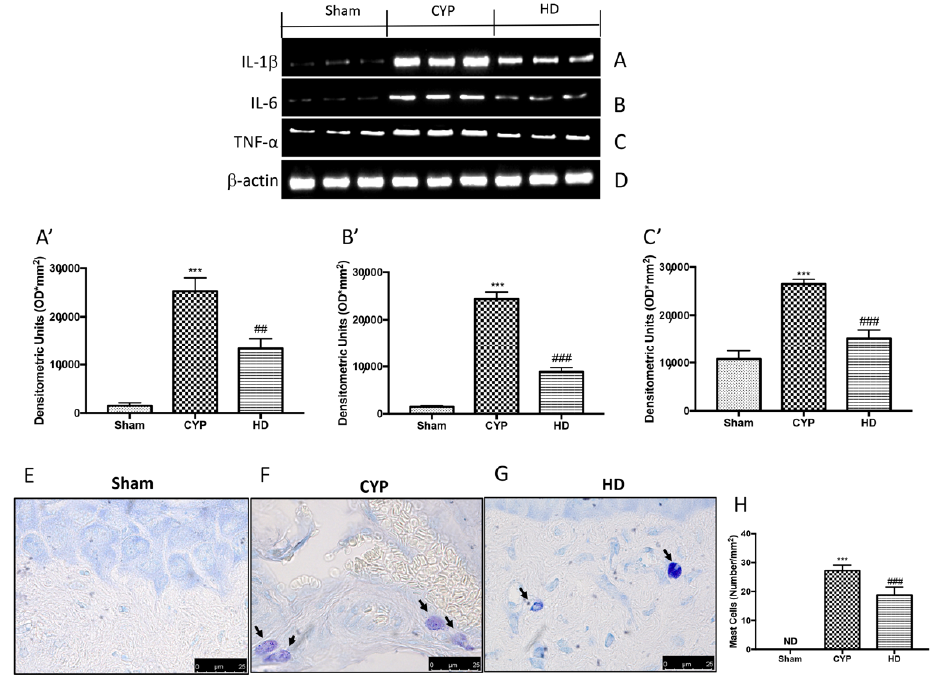
Figure 4. Effect of HD on the release of proinflammatory cytokines and mast cell (MC) activation in the bladders of mice after repeated CYP injections. Western blot analysis showed that IL-1 β expression was significantly increased in the CYP group, while treatment with HD decreased the expression of IL-1 β ( A , A’ ). IL-6 expression was increased after repeated CYP injections; treatment with HD decreased levels of this cytokine ( B , B’ ). TNF- α expression was significantly increased in the CYP group, while treatment with HD decreased the expression of TNF- α ( C , C’ ). Mast cell infiltration was evaluated by toluidine blue staining in the chronic cystitis model. Mast cells were characterized by dark-lilac-blue granules. Protein lysates were also incubated with a β -actin antibody ( D ) in order to verify that all samples had been loaded in equal quantities. ( E ) Sham group. ( F ) CYP group. ( G ) HD group. ( H ) Mast cell numbers per unit area of tissue (mast cell density). Values are means ± SD of five animals for each group; *** p < 0.001 vs. Sham; ## p < 0.01 vs. CYP; ### p < 0.001 vs. CYP.